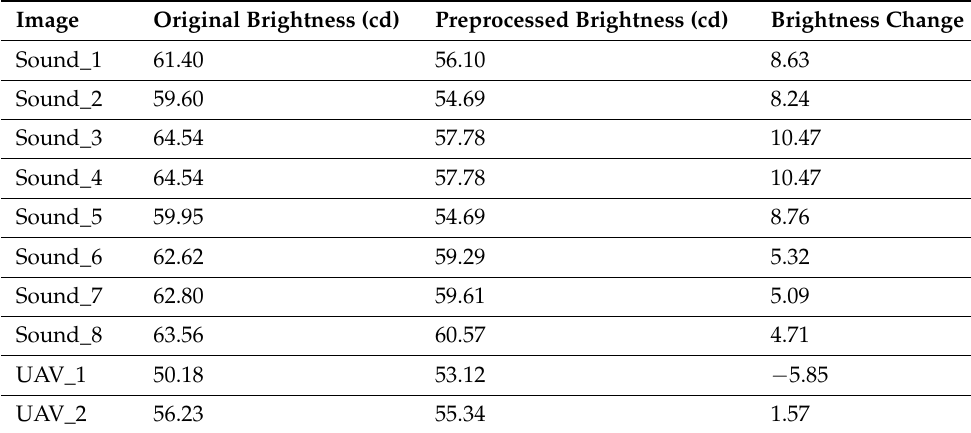
Table 3. Comparison of brightness values of original and preprocessed sound and UAV images.